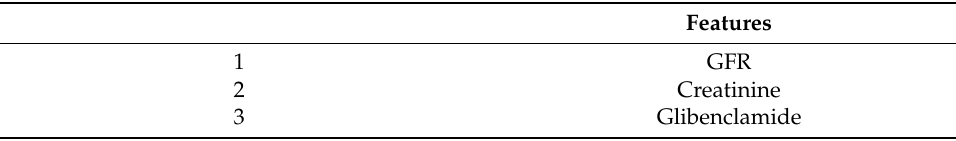
Table 5. Three key features identified by